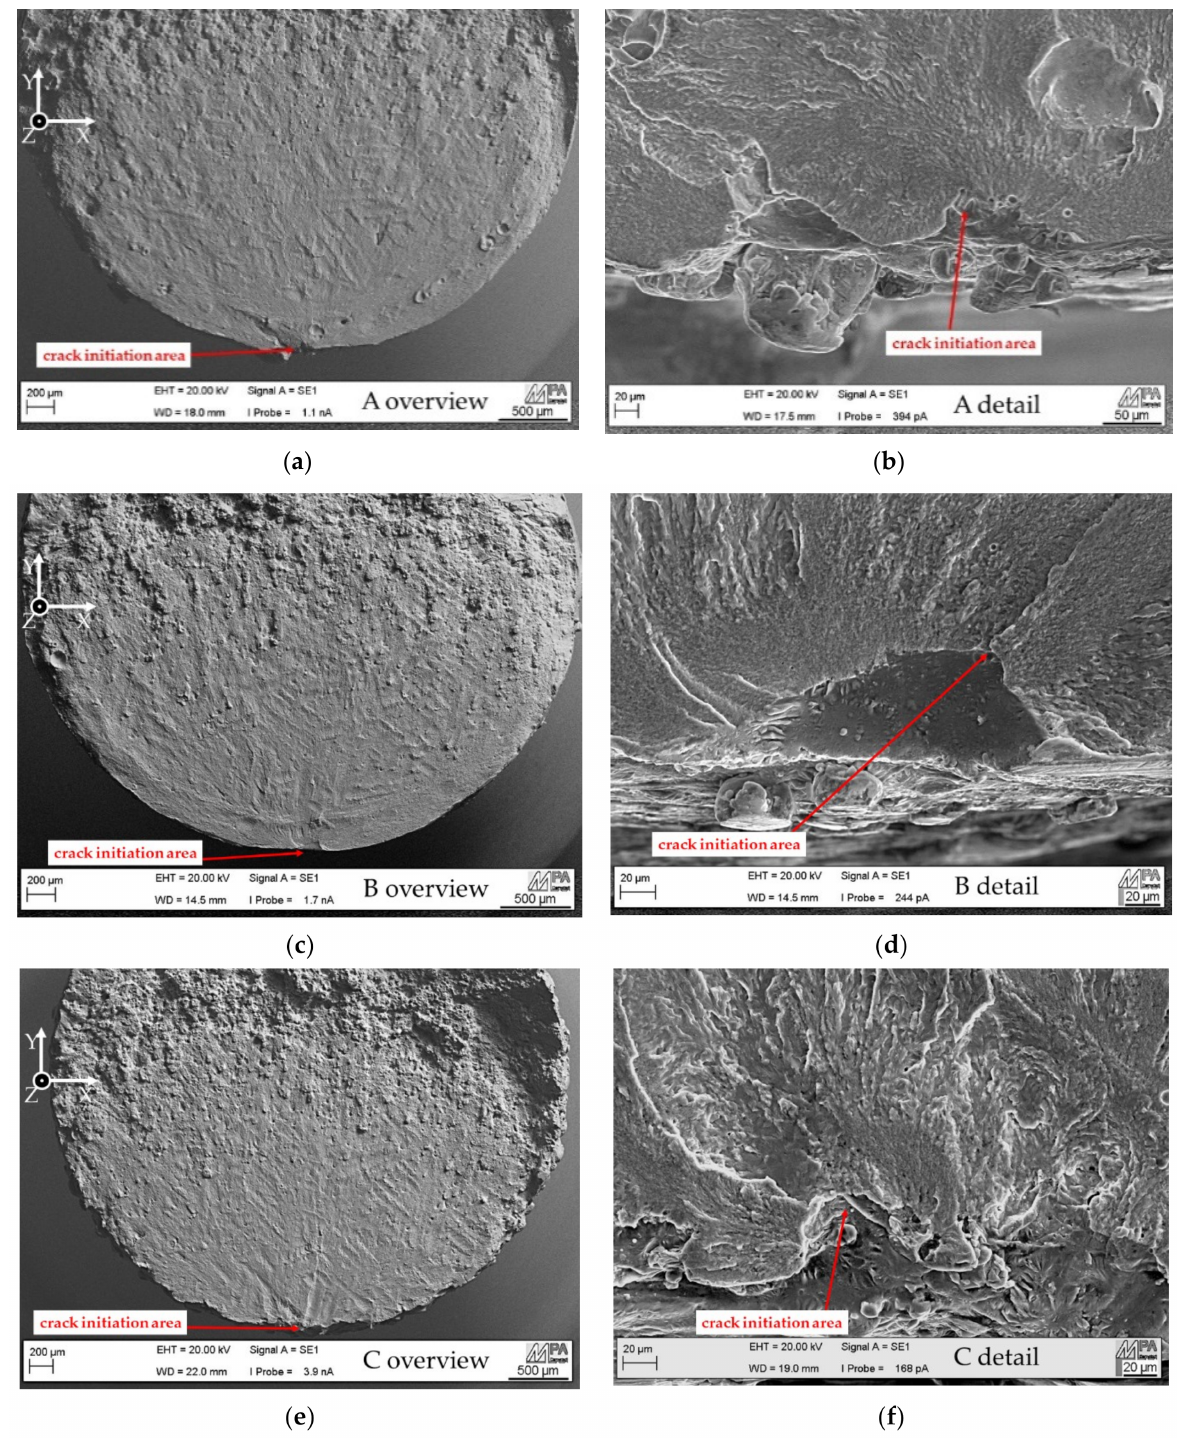
Figure 11. ( a ) Exemplary overview of a breaking surface of A. ( b ) Detailed view of a crack initiation area of A, ( c ) exemplary overview of a breaking surface of B, ( d ) detailed view of the crack initiation area of B, ( e ) exemplary overview of a breaking surface of C, ( f ) crack initiation area of C. All breaking surfaces inside one charge are of similar character, regardless of the stress amplitude. R = 0.1.